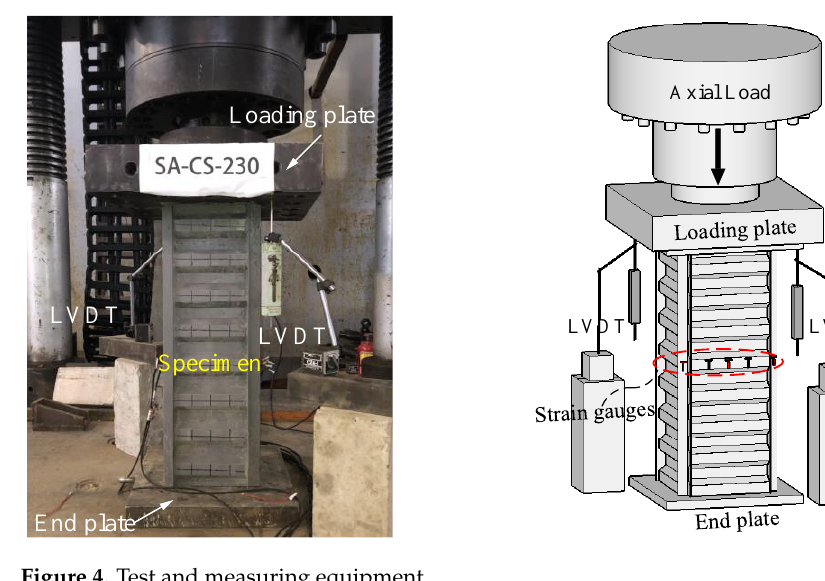
Figure 4. Test and measuring equipment.